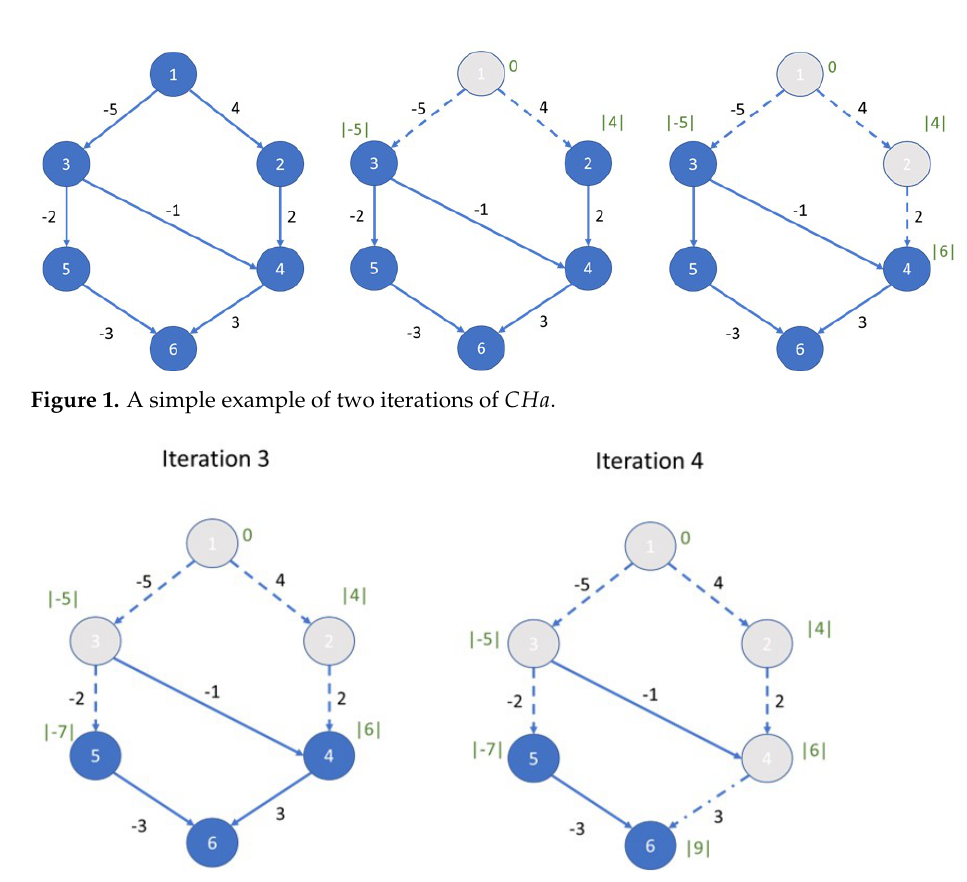
Figure 2. The last iterations of CHa